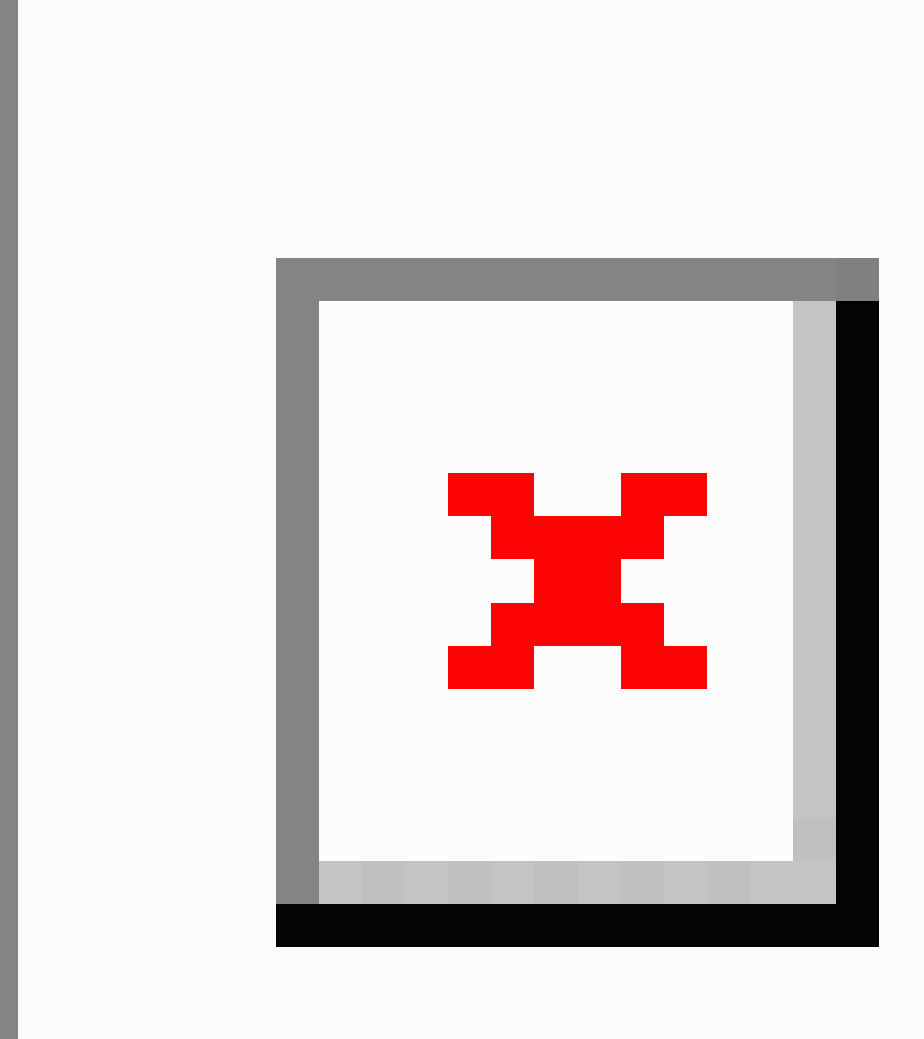
Figure 4. PersonA self-management